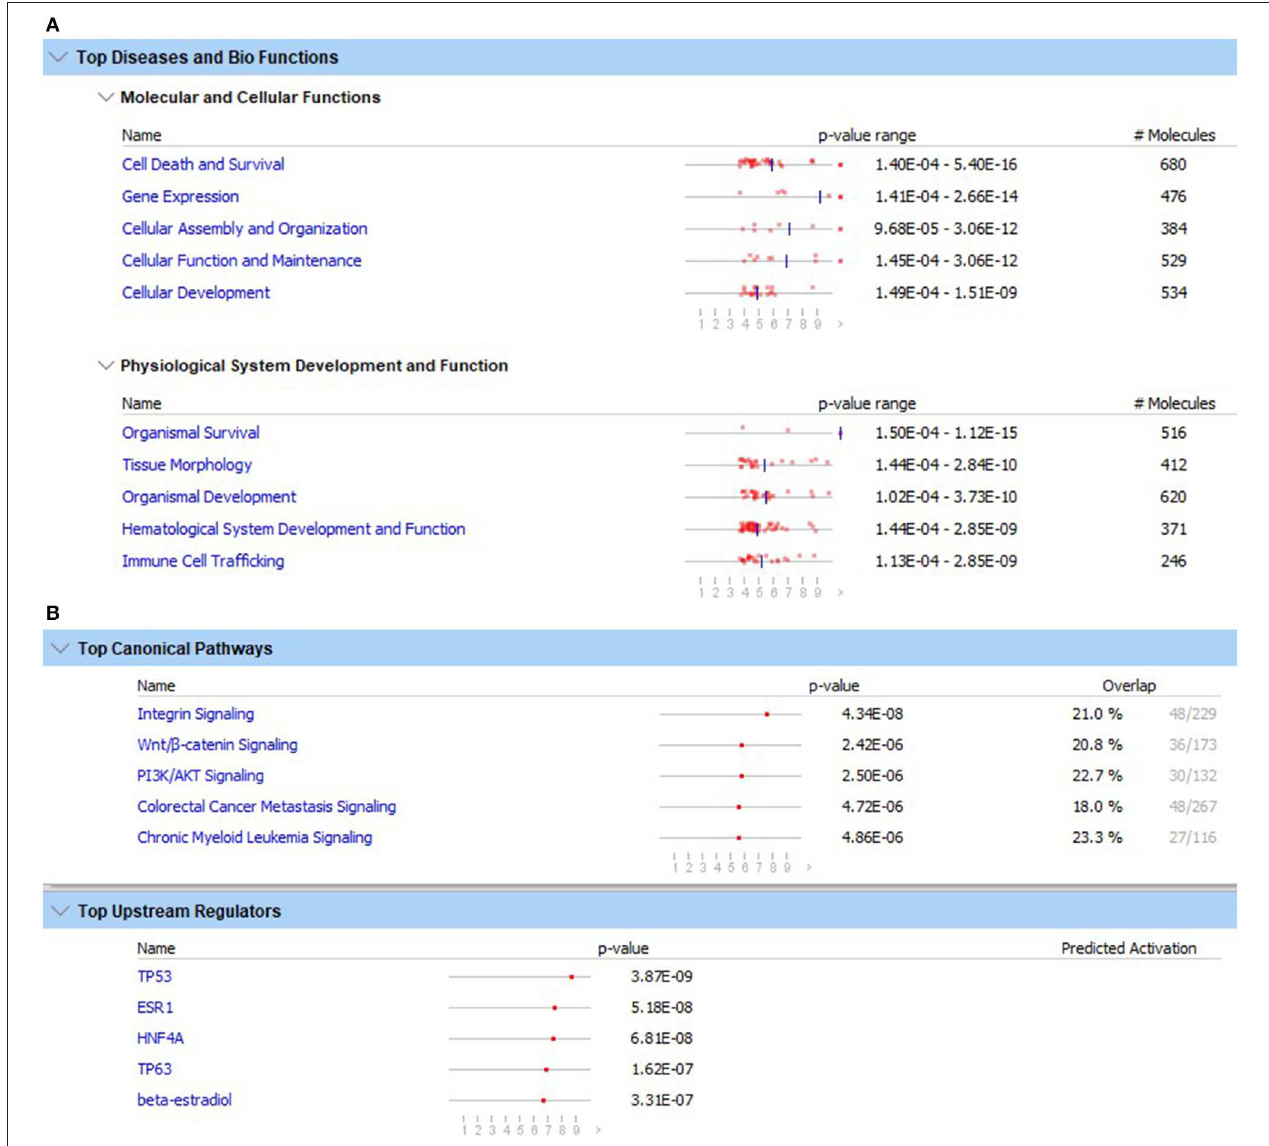
FIGURE 1 | Top five diseases and biological functions (A) and top five canonical pathways and upstream regulators (B) with the lowest likelihoods ( p -value) of the associations/overlaps between the differentially expressed gene set (both up- and down-regulated) and the pathways/biological processes by random chances in the Qiagen Ingenuity Pathway Analysis using the list containing ENTREZ numbers and up- and down-regulated DEG. The dots in horizontal lines are the negative log transformation of p